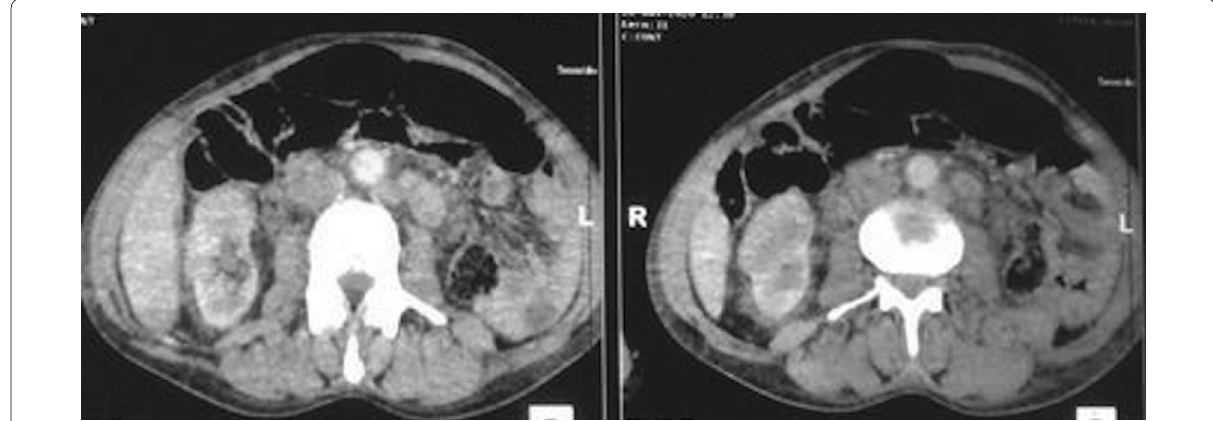
Fig. 1 Abdominal CT scan with injection of contrast product showing a right polar renal lesion of heterogeneous density very suspicious of malignancy